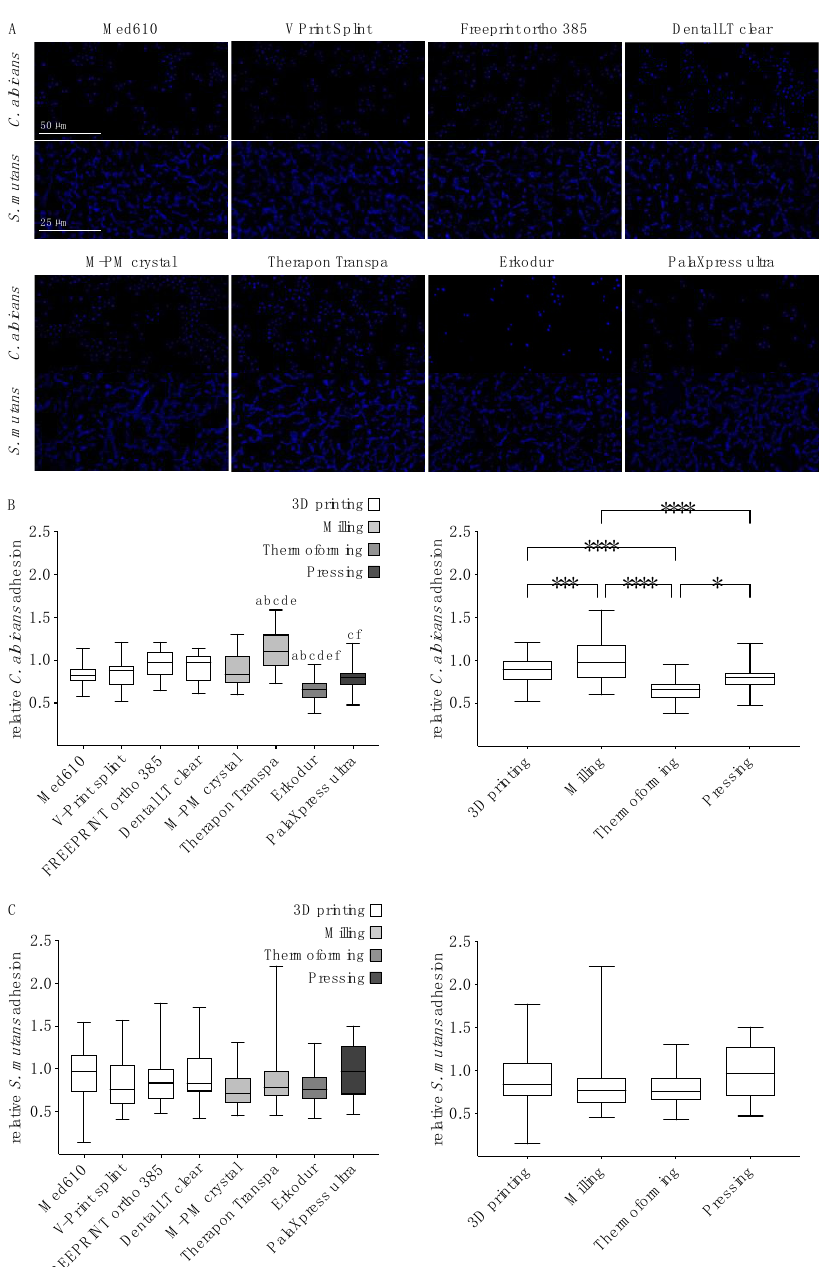
Figure 1. Microbial adhesion to oral splint resins. ( A ) Hoechst staining (blue fluorescence) exemplarily visualizes the adhesion of C. albicans ( upper rows) and S. mutans ( lower rows) to the test materials (columns). C. albicans yeast cells form small heterogenous clusters; S. mutans cells are arranged in typical chain formations. ( B ), relative C. albicans adhesion according to the luminescence assay. C. albicans adhesion shows significant differences between test materials ( left ). a p < 0.05 compared with Med610, b p < 0.05 compared with V-Print splint, c p < 0.05 compared with FREEPRINT ortho 385, d p < 0.001 compared with Dental LT clear, e p < 0.001 compared with M-PM crystal, f p < 0.0001 compared with Therapon Transpa. Arrangement of the data according to the underlying manufactur- ing methods ( right ) also shows significant differences for C. albicans adhesion. * p < 0.05, *** p < 0.001, **** p < 0.0001. Glass was used for normalization (=1.0). ( C ), relative S. mutans adhesion according to the luminescence assay. There were no significant differences in S. mutans adhesion between the test materials ( left ) or between the manufacturing methods ( right ). Glass was used for normalization